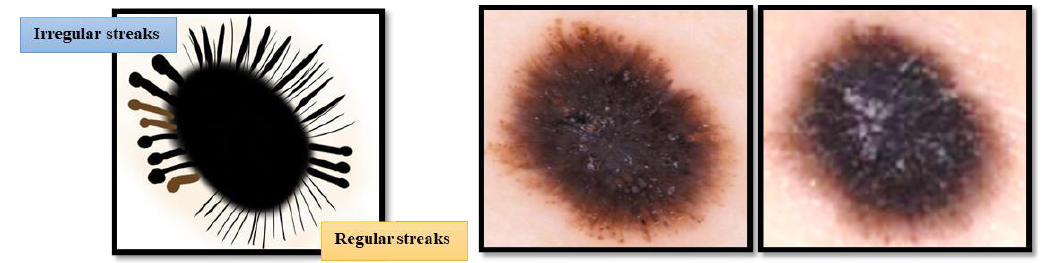
Figure 5. Streaks and globules dermoscopic structures.